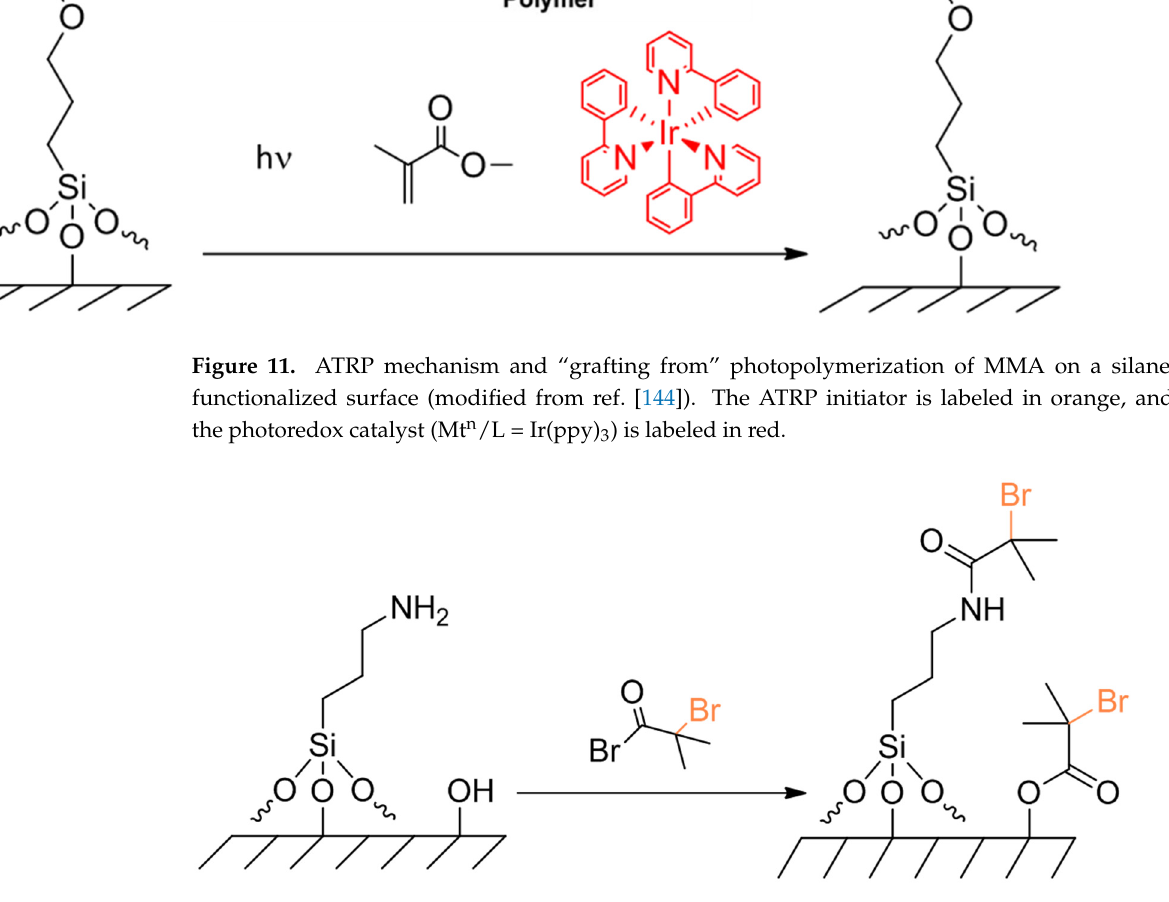
Scheme 15. Coupling of an ATRP initiator (orange) to an amino-functionalized